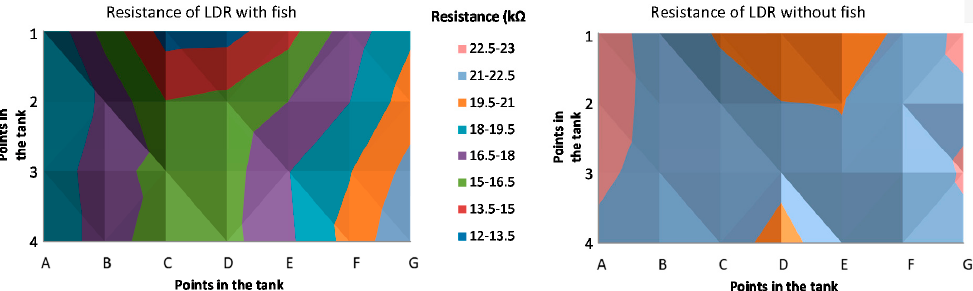
Figure 16. Average LDR resistance in different point with and without the fish.